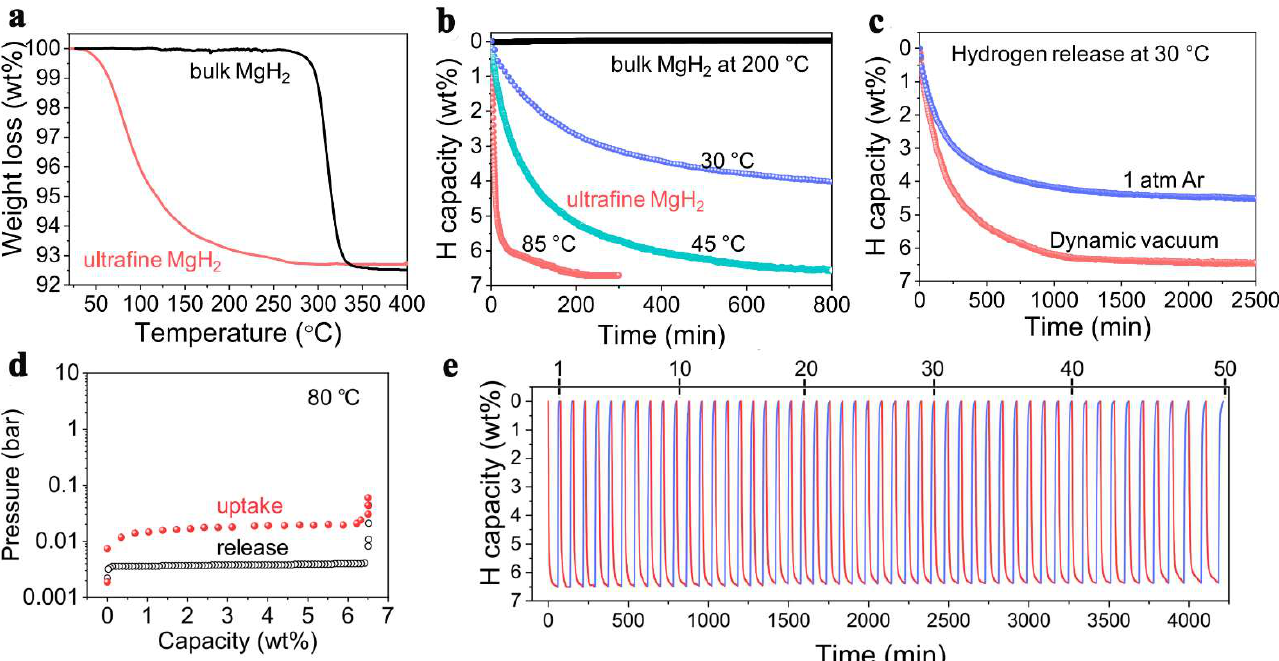
Figure 8. Non-isothermal hydrogenation curves ( a ); isothermal hydrogenation curves at different temperatures ( b , c ) and the corresponding Arrhenius plot of MgH 2 with and without nano-FeCo ( d ); non-isothermal dehydrogenation curves ( e ); DSC curves with a heating rate of 5 °C min −1 of MgH 2 with and without nano-FeCo ( f ); isothermal dehydrogenation curves of MgH 2 + nano-FeCo compo- site at 250, 275, 300, 350 °C ( g ); dehydrogenation (in red) and rehydrogenation (in green) curves of MgH 2 + nano-FeCo composite in the 1st, 2nd, 4th, 6th, 8th and 10th cycle ( h ). Reprinted/adapted with permission from Ref. [201]. 2019, Royal Society of Chemistry.